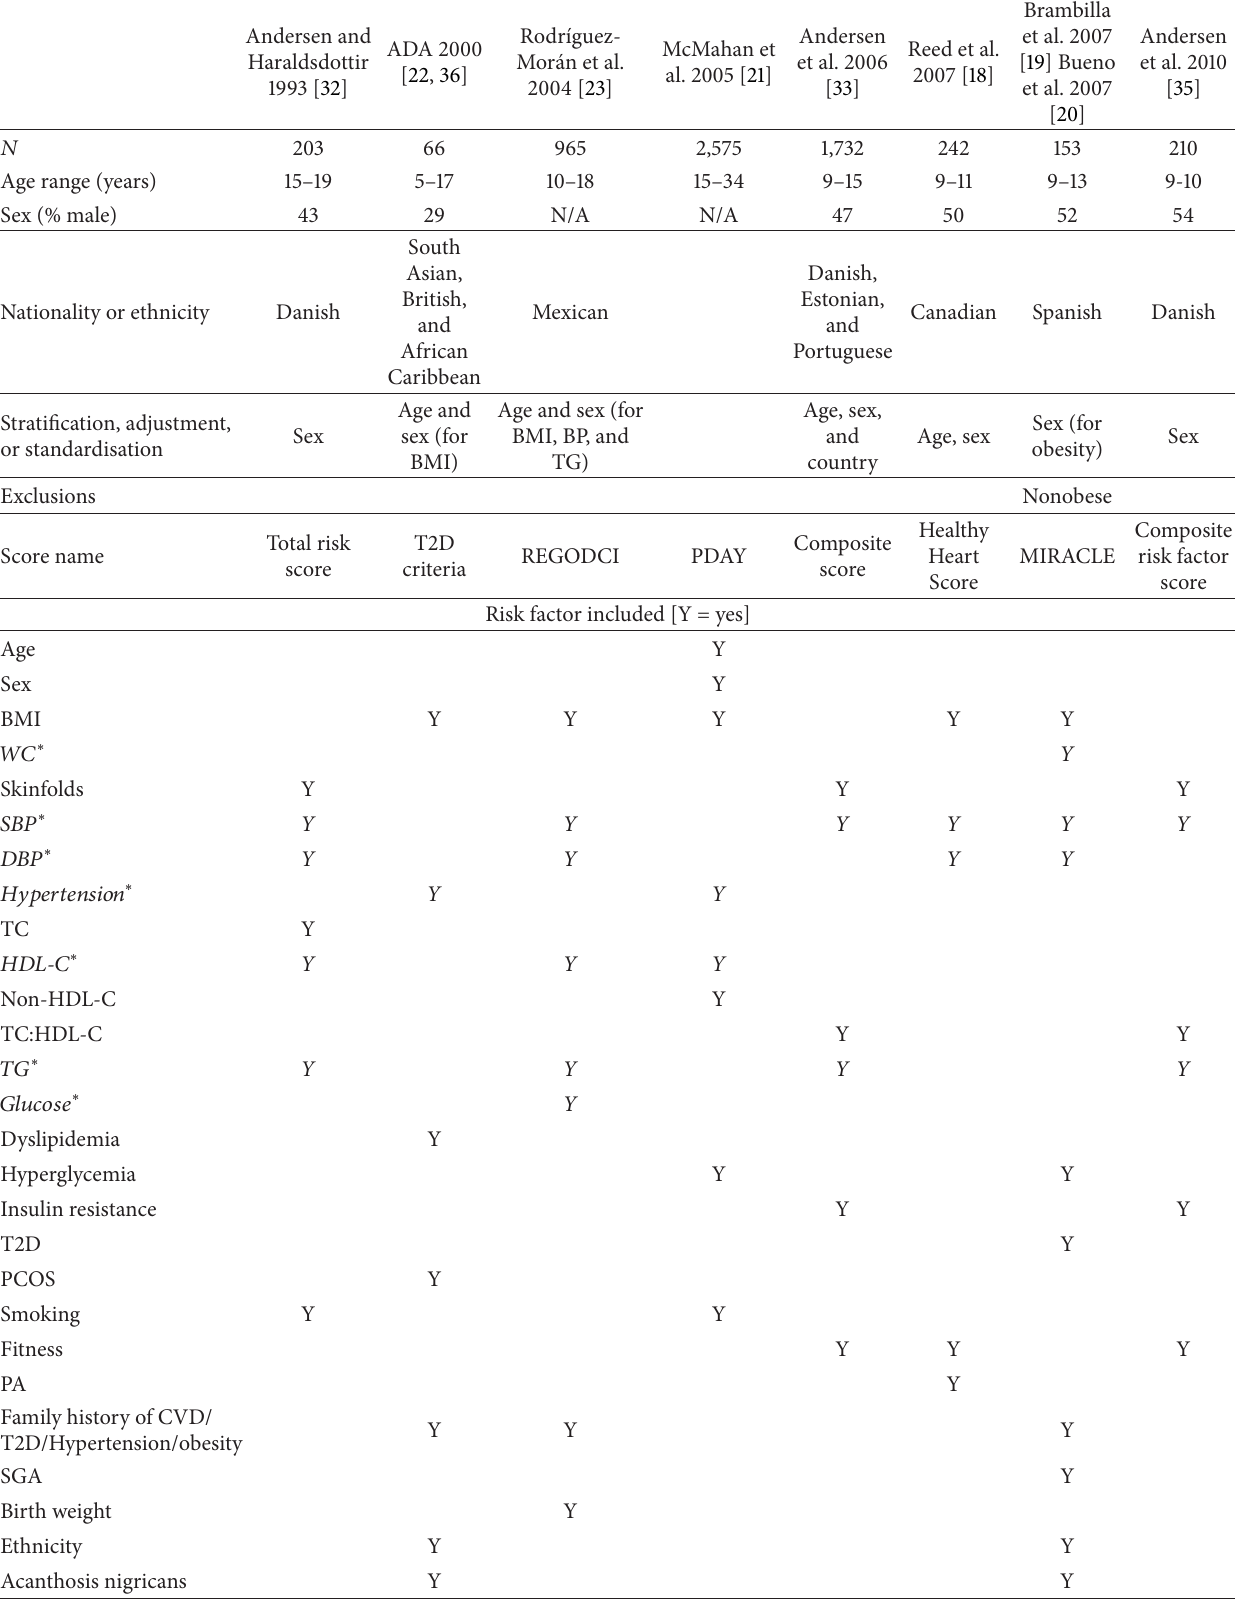
Table 1: Cardiometabolic risk scores developed for children and adolescents. Andersen